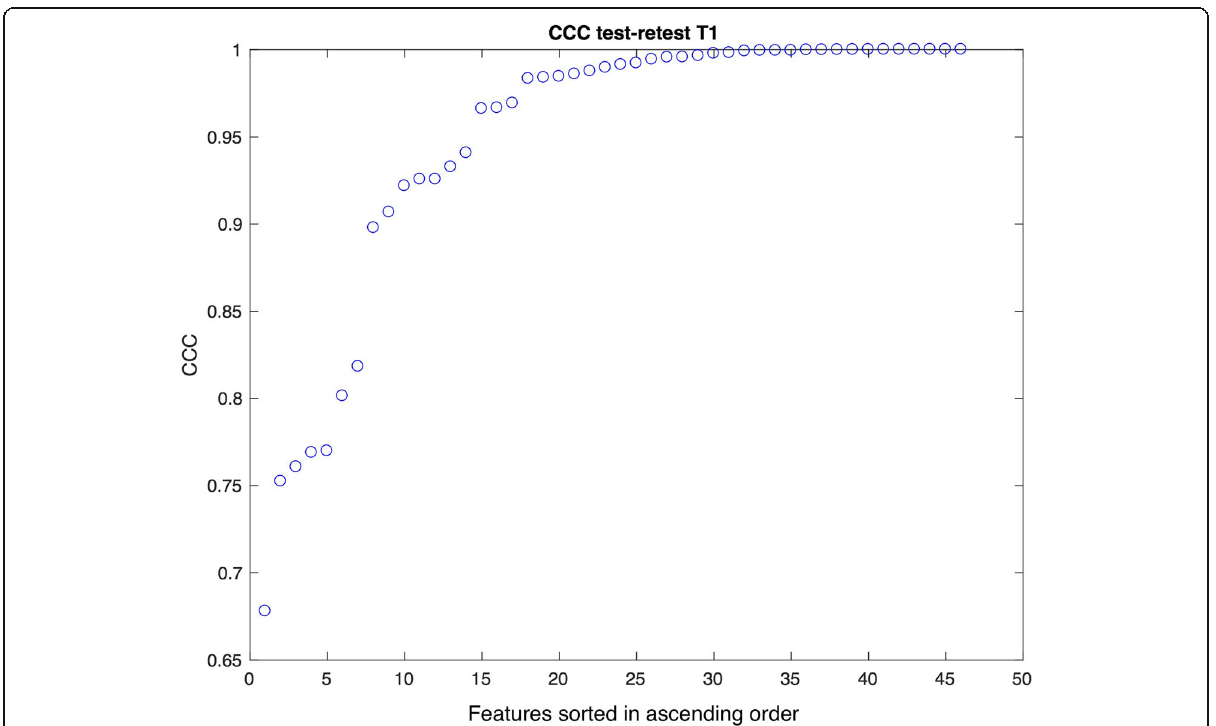
Fig. 4 T1-weighted imaging. Concordance correlation coefficient (CCC) for 46 features (14 statistics and 32 texture features) in the test-retest experiment, sorted in ascending